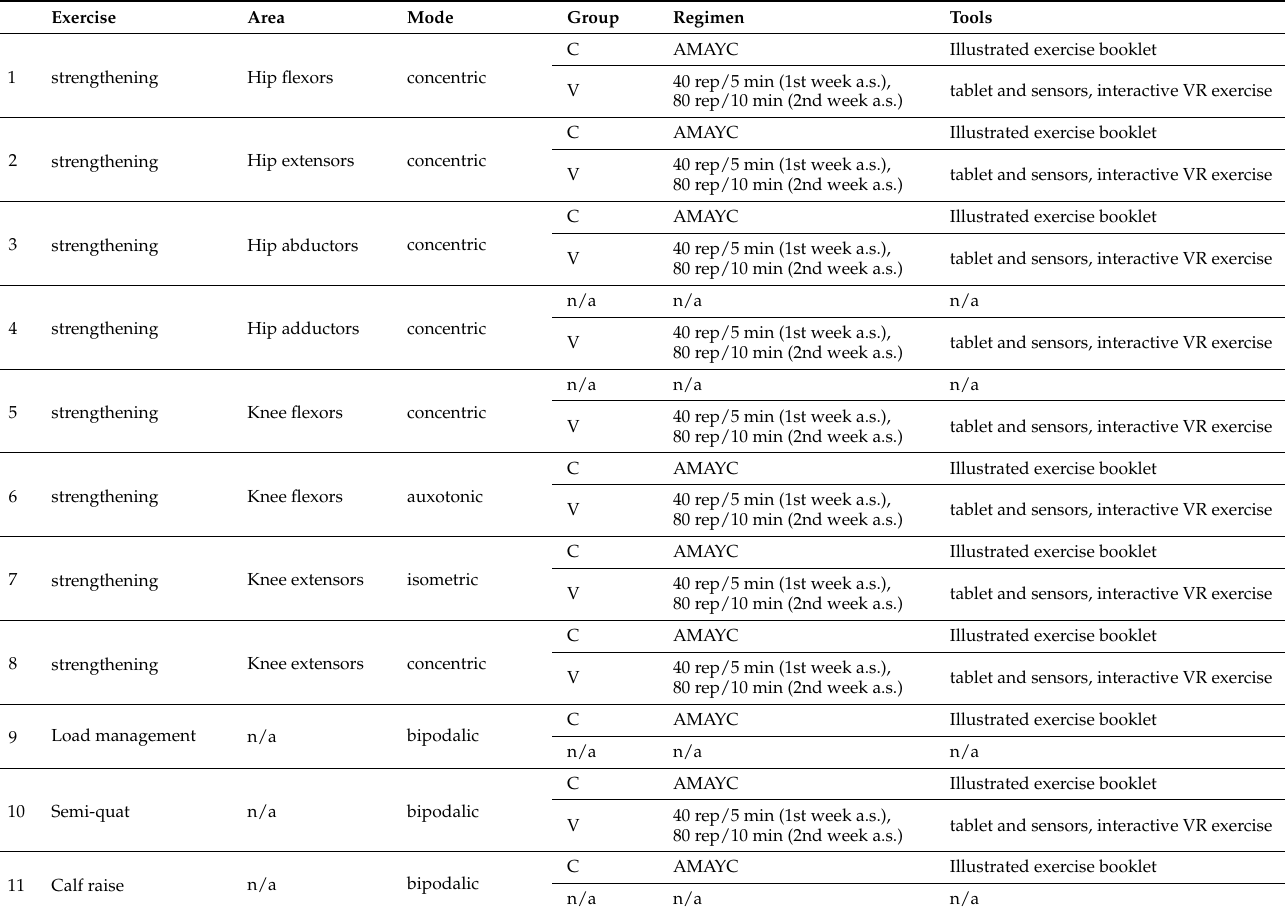
Table 1. Home rehabilitation regimen after total hip arthroplasty. Control group I and VRRS group (V), respectively, received interventions through an illustrated booklet and the telerehabilitation system. “AMAYC“: “as much as you can”; 40 rep/5 min: 40 repetitions within 5 min; a.s.: after sur- gery; n/a: not applicable; VR: virtual reality technology.